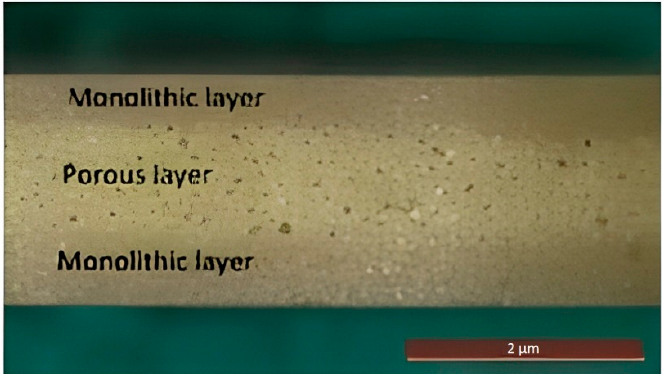
Figure 14. Porous multilayer BT material (Reprinted from Ref. [90], copyright (2017), with the kind permission of Acta Materialia Inc. Published by Elsevier Ltd.).